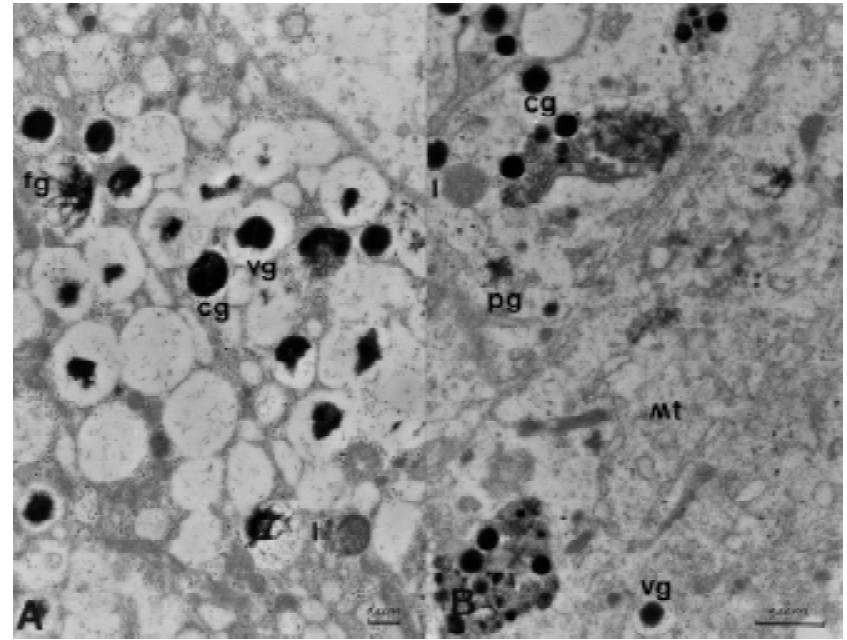
Figure 2 - Types of pigment granules (p). A , Heterozygote. B , Mutant. fg, Fibrous granule; cg, compact granule; vg, vesicular granule; pg, polymorphous granule. Note the presence of lysosomal structures (l) and microtubules